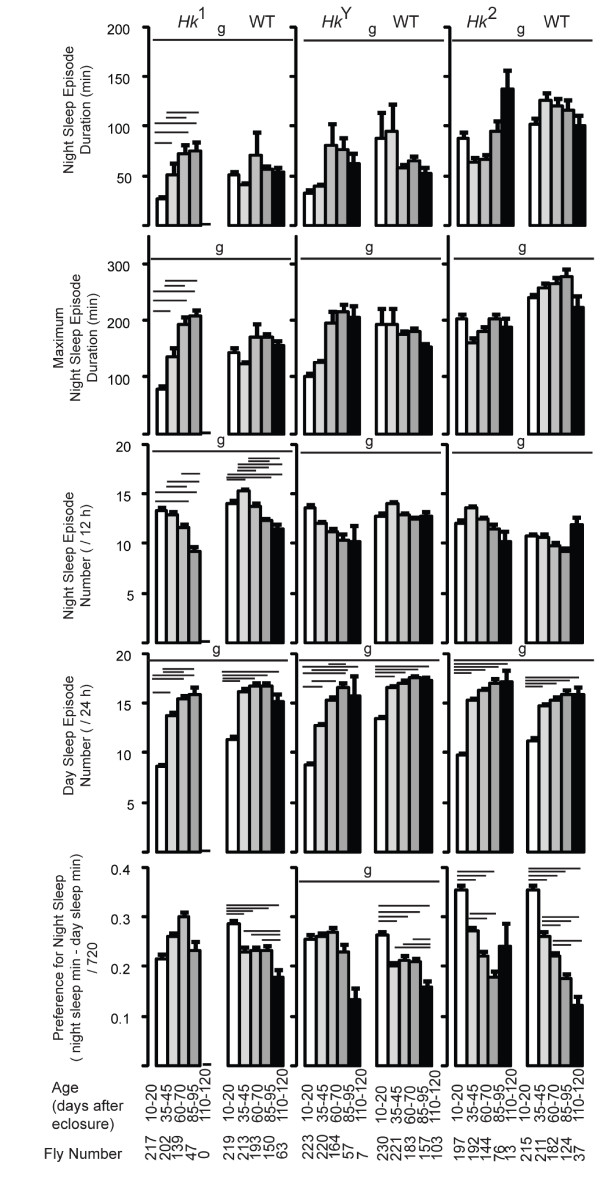
Sleep parameters during night and day in all flies. Values are mean + SEM (eleven 12-hour intervals averaged per each fly, and then averaged across all flies). The number of flies tested at each age is shown below each bar. Genotype (g) effects were tested across all ages (Kruskal-Wallis test, p < 0.05). Horizontal bars indicate significant age-related effects within each genotype (Friedman test followed by Wilcoxon signed-rank test, p < 0.05).